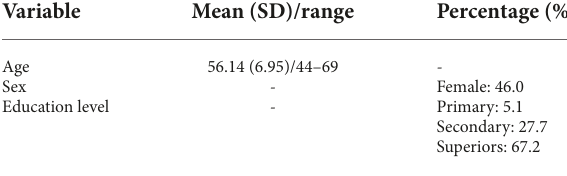
TABLE 1 Demographic characteristics of